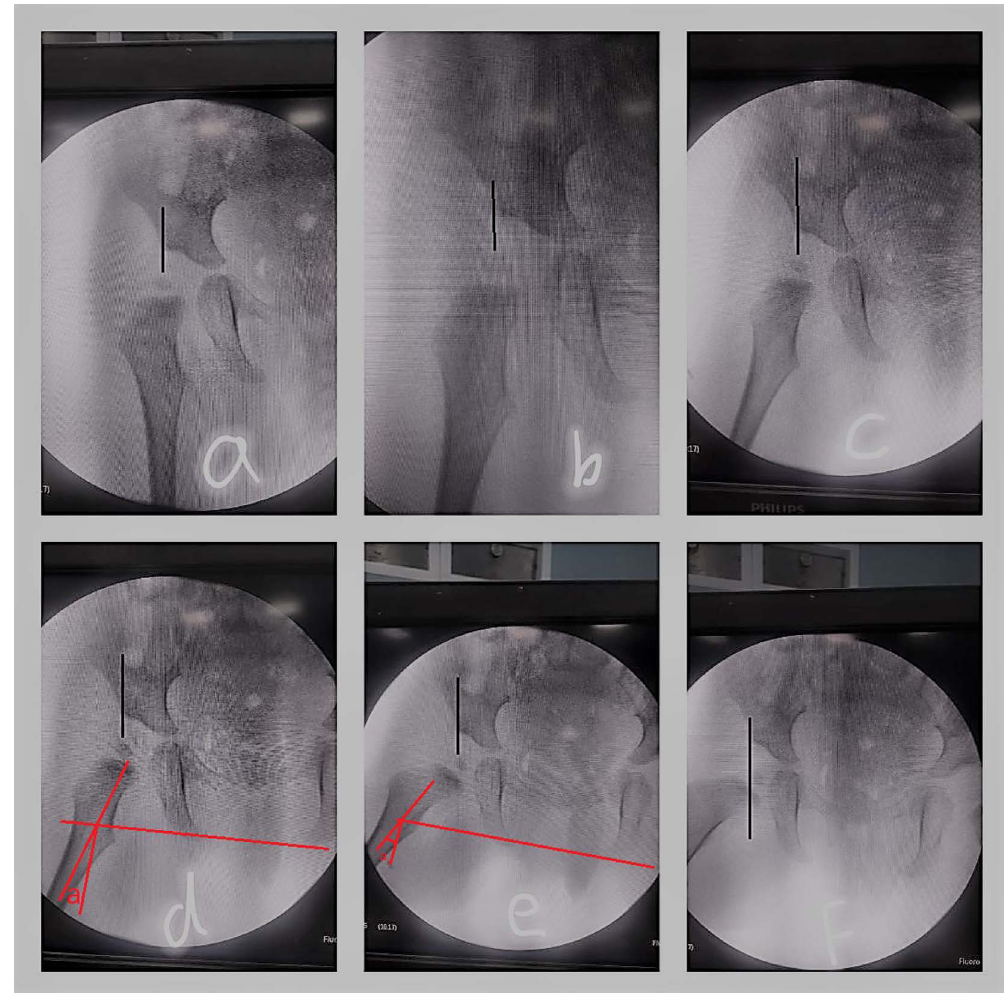
Figure 4. Intraoperative estimation of varisation (abduction then internal rotation of the hip to get the ossi fi c nucleus completely covered by the acetabulum): Hip is in neutral position (a). Hip is being abducted (b, c, d). Hip is being internally rotated (e, f). Black line is Perkin ’ s line. “ a angle ” is the amount of hip abduction which was needed to make the nucleus completely covered by the acetabulum, which equals the amount of needed varus. Note that rotation was needed (e, f) to make the ossi fi c nucleus completely inside the acetabulum.